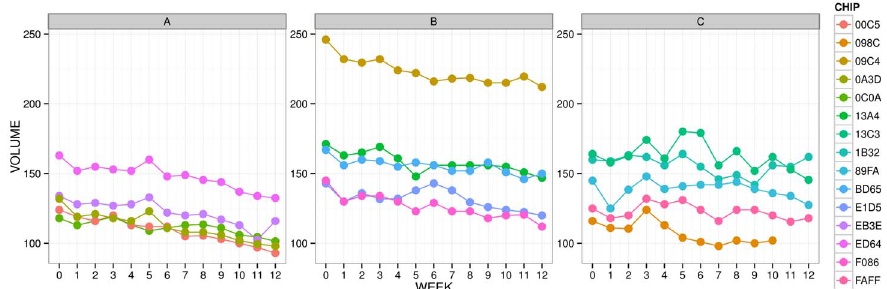
Figure 1. Sperm volume profiles for European Eels grouped by Treatment. CHIP variable was used to indicate each eel. Eel 098C did not present sperm volume in the last two weeks. ) is the random factor and Aquarium C, respectively. b i * N (0, s b 0 for representing the difference between the initial volume of sperm